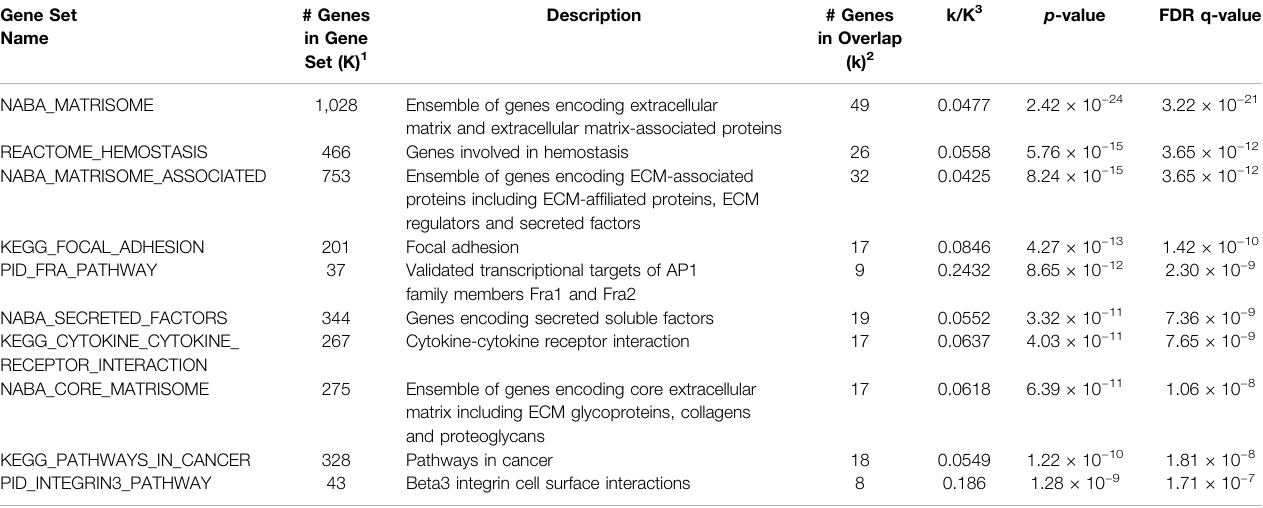
TABLE 1 | Canonical pathways differentially expressed by Rb2/Rg3 combination treatment according to GSEA analysis (10 pathways with lowest p -value are